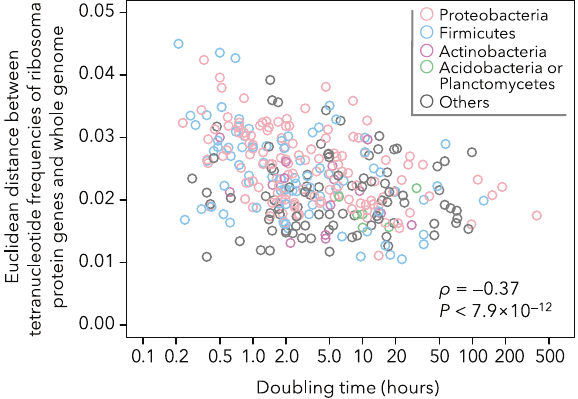
Fig. 6 Correlation between bacterial doubling time and the degree of tetranucleotide frequency anomalies in ribosomal protein genes. The result of Spearman ’ s correlation test is indicated at the bottom